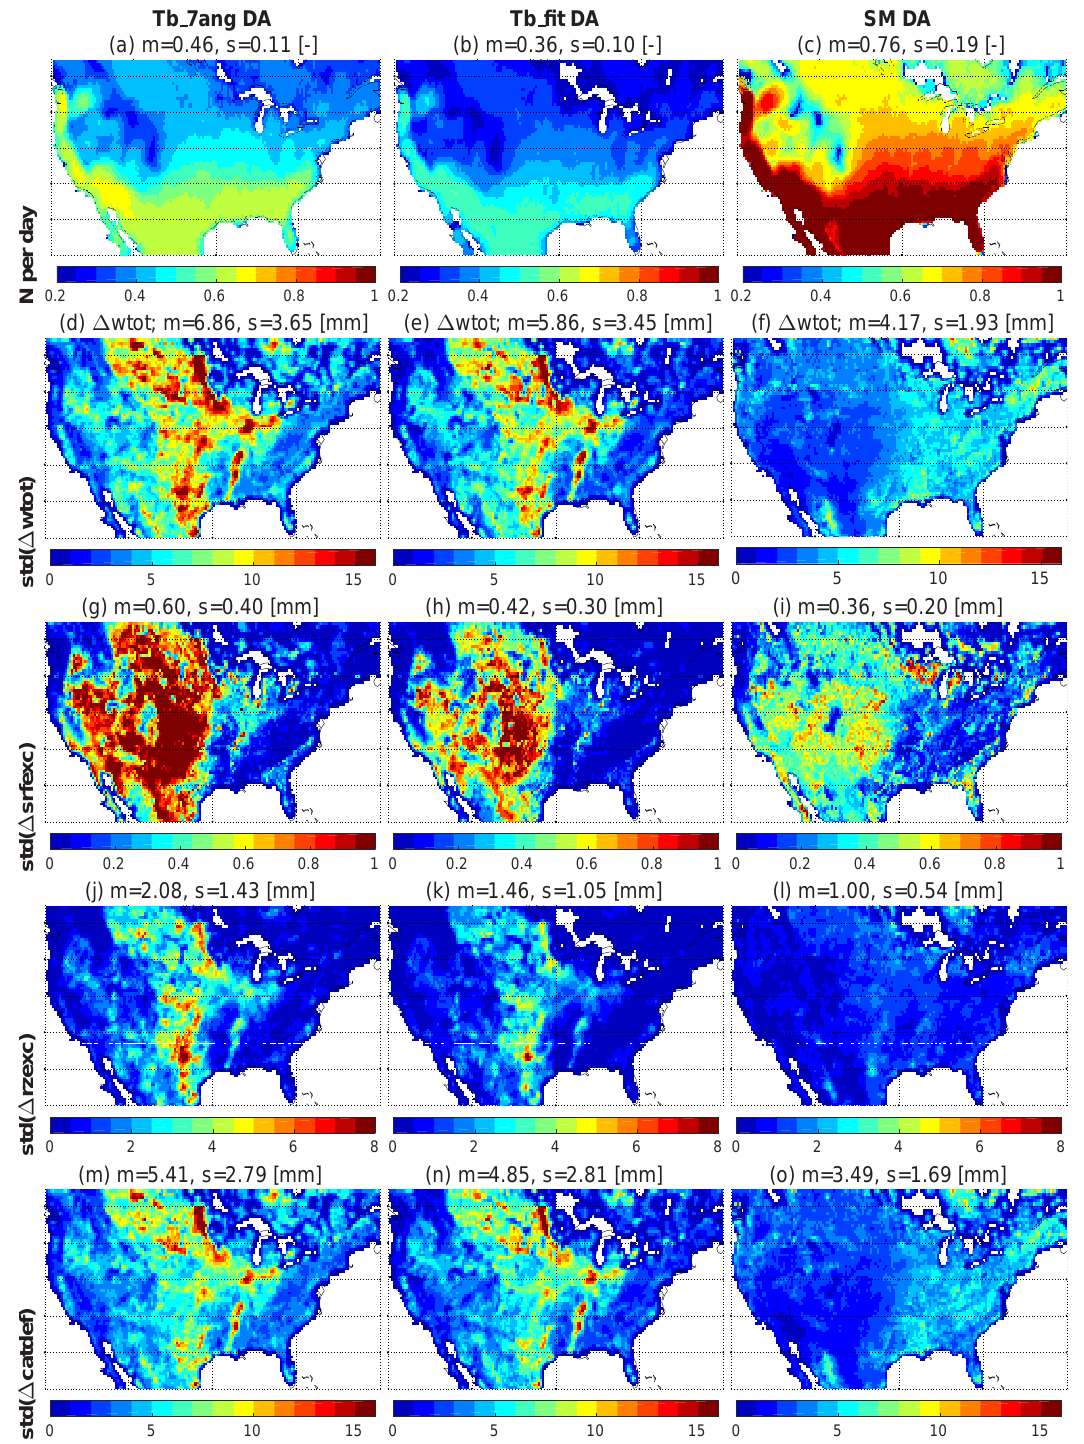
Figure 6. Statistics of the increments, calculated for the period from 1 July 2010 to 1 May 2015. Number of increments per day for (a) Tb_7ang assimilation, (b) Tb_fit assimilation, and (c) SM assimilation. Temporal standard deviation of total profile water (wtot) in- crements for (d) Tb_7ang assimilation, (e) Tb_fit assimilation, and (f) SM assimilation. ( g , h , i ) Same as ( d , e , f ) but for srfexc increments. ( j , k , l ) Same as ( d , e , f ) but for rzexc increments. ( m , n , o ) Same as ( d , e , f ) but for catdef increments. The titles show the spatial mean (m) and standard deviation (s) across each